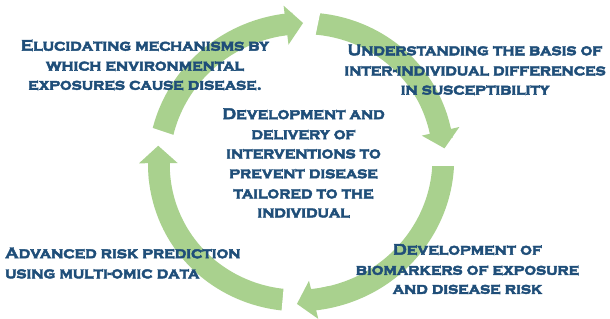
Fig. 1 | Hallmarks of precision environmental health. Precision Environmental Healthseekstopreventdiseasebyunderstandingriskandtailoringinterventionsat the level of the individual. To reach this goal, precision environmental health research seeks to understand mechanisms by which environmental exposures cause disease and the basis for interindividual differences in susceptibility. This